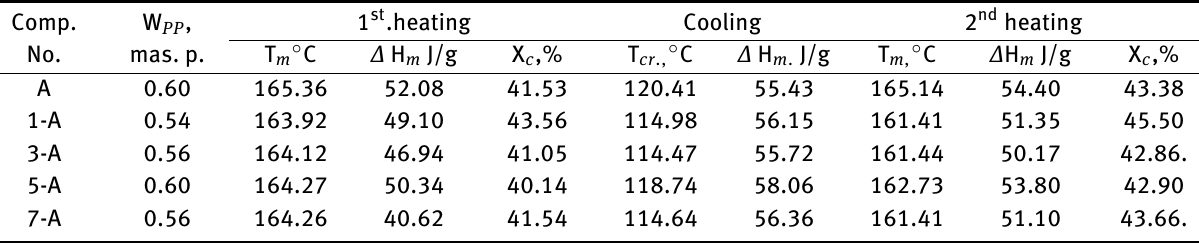
Table 5: Results of differential scanning calorimetry (DSC) measurements of the un-weathered composites Comp.